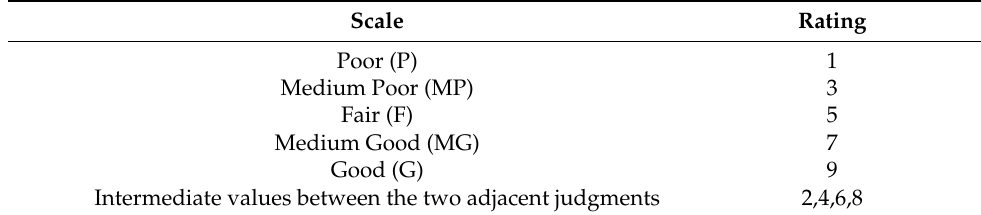
Table 3. Linguistic scales of alternative’s rating for TOPSIS model